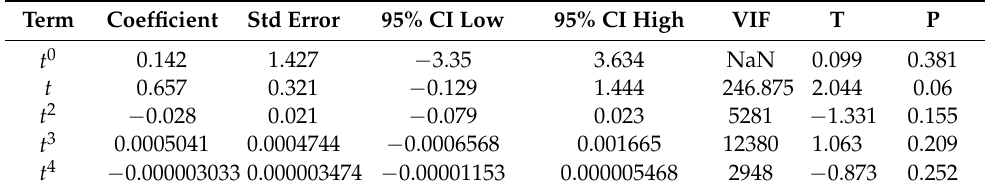
Table 5. Results of statistical analysis, for the interpolation (using fourth-degree polynomial) of lettuce diameter crowns variation over time, grown in soil with 4.5% zinc concentration.